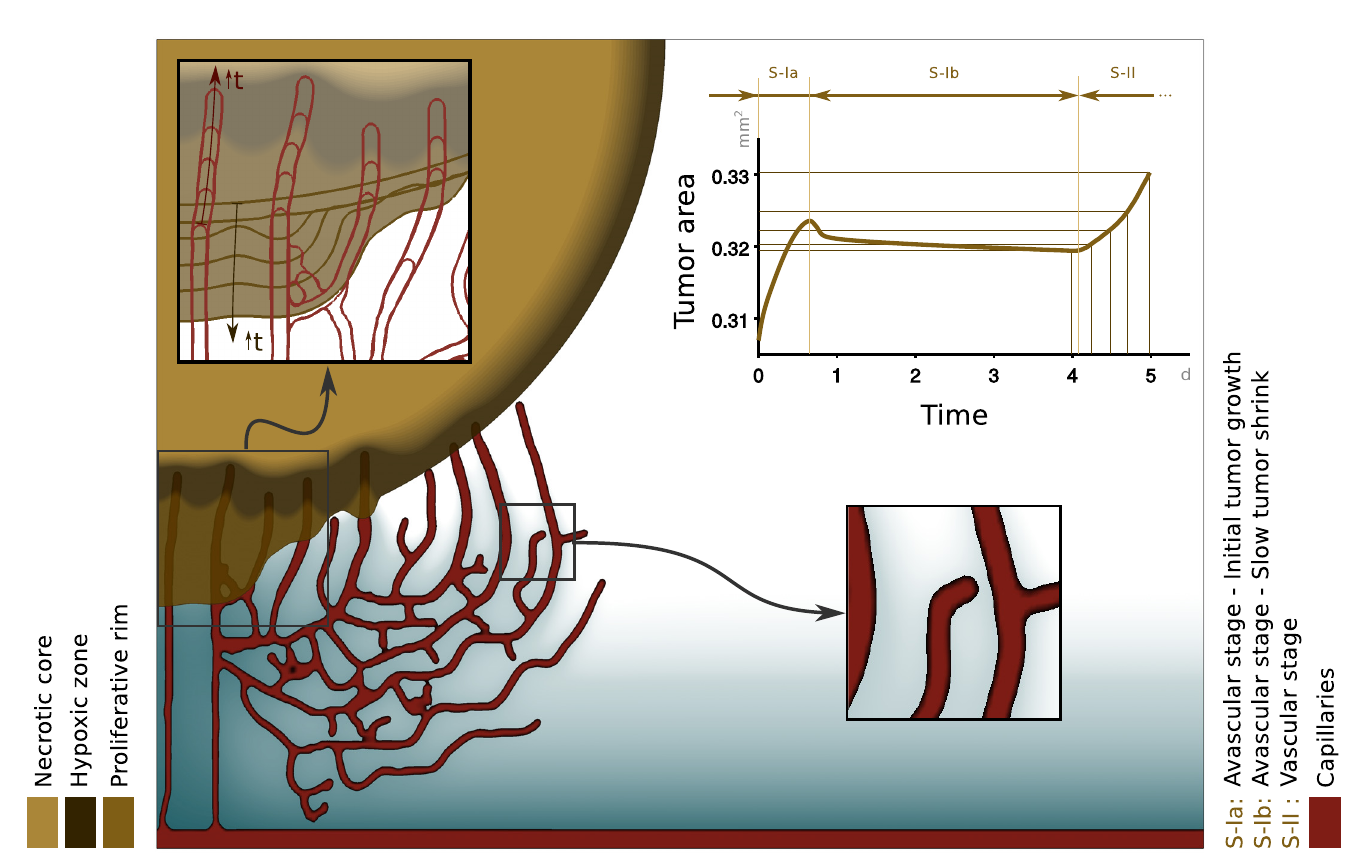
Fig 6. Simulation of vascular tumor. Hypoxic tumor cells (dark brown; see color scales in the bottom left corner) release tumor angiogenic factor (not shown in the plot for clarity) that promotes the growth of capillaries (red). The new vasculature brings additional nutrients (blue scale) to the tumor favoring its growth (see the tumor area evolution in the top right inset). The top left inset shows through contour lines the time evolution of the tumor and the capillaries that have penetrated it. The bottom right inset shows a tip endothelial cell that is about to anastomose with other capillary and the nutrient distribution in the surroundings of the neovasculature. As expected, the nutrient concentration decreases with the distance to the capillaries.